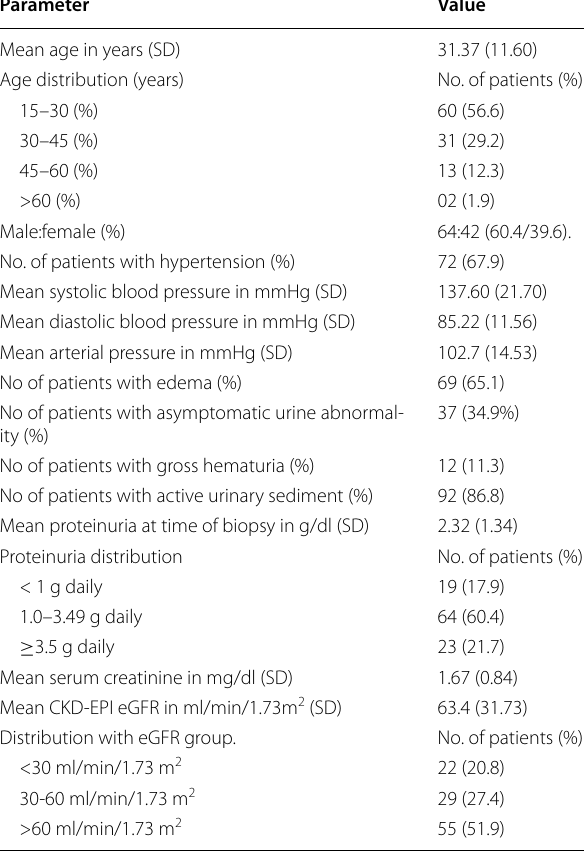
SD standard deviation, CKD-EPI chronic kidney disease epidemiology collaboration formula